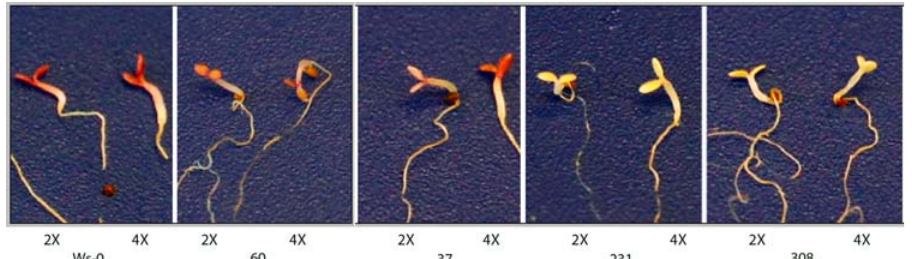
Figure 4. Photograph of seedlings showing anthocyanin accumulation. Seedlings were grown on 6% sucrose medium for 15 days. The transgenic line numbers are indicated below the photograph. 2x is diploid, 4x tetraploid.